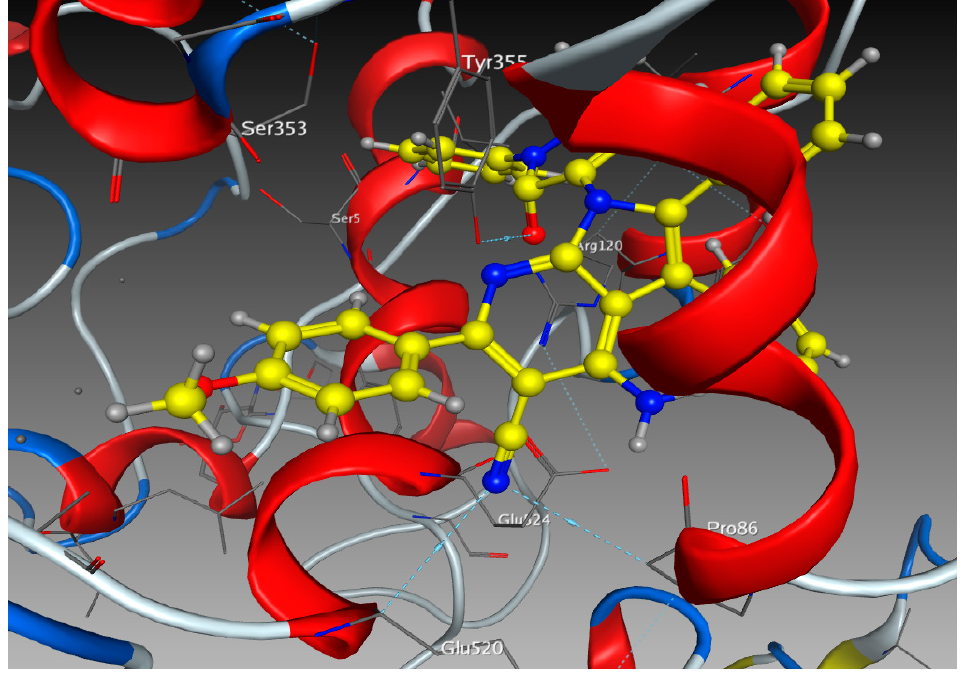
Figure 2. The best binding mode of compound 3l .